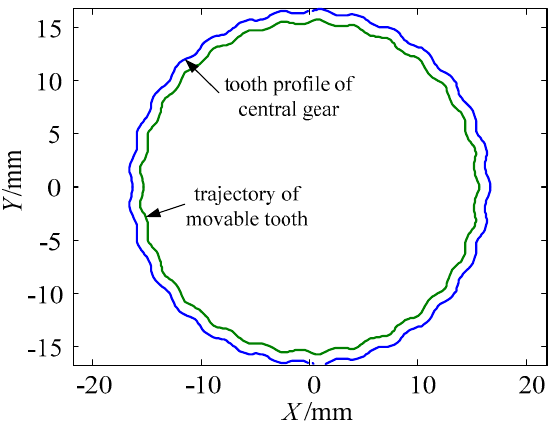
Figure 4. The tooth profile of the central gear and trajectory of the movable tooth.